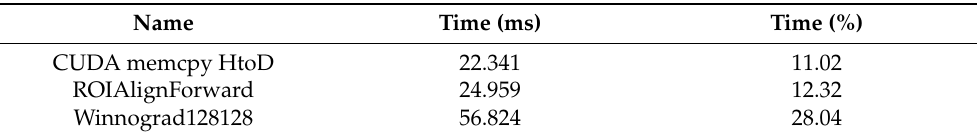
Table 1. Parameters related to the network reasoning